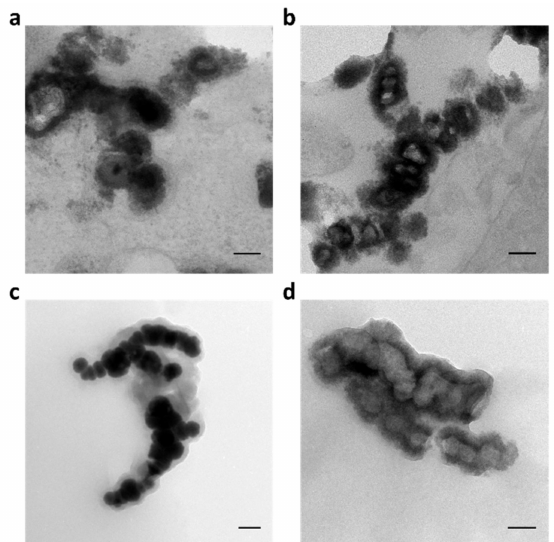
Figure 3. TEM characterization of intracellular distribution and the conformational change of ZVI@SiO 2 and ZVI@mSiO 2 NPs after 24-h treatment. ( a ) Most ZVI@SiO 2 NPs internalized by OEC-M1 cells remained solid particle structures similar to that of the as-synthesized state. ( b ) ZVI@mSiO 2 NPs showed significant transformation into hollow structure within the cells. ( c ) ZVI@SiO 2 NPs purified from the OEC-M1 cells after 24-h of NPs treatment still remained in their original structure. ( d ) The purified ZVI@mSiO 2 NPs transformed into hollow structure after 24-h treatment. Scale bar = 100